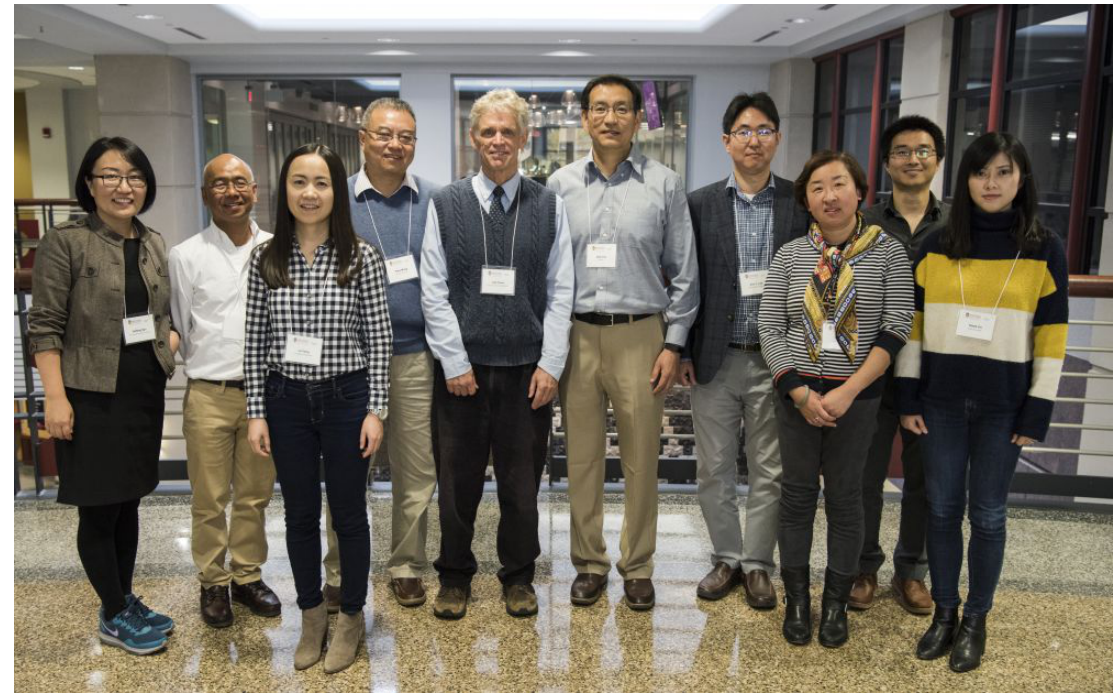
Figure 3: 2018 Frees Retirement Workshop. Pictured with Jed are many of his former doctoral students. From left to right, Ji- afeng Sun, Emiliano Valdez, Lu Yang, Ping Wang, Jed, Yu (Jack) Luo, Gee Lee, Jie Gao, Peng Shi, Xiaoli